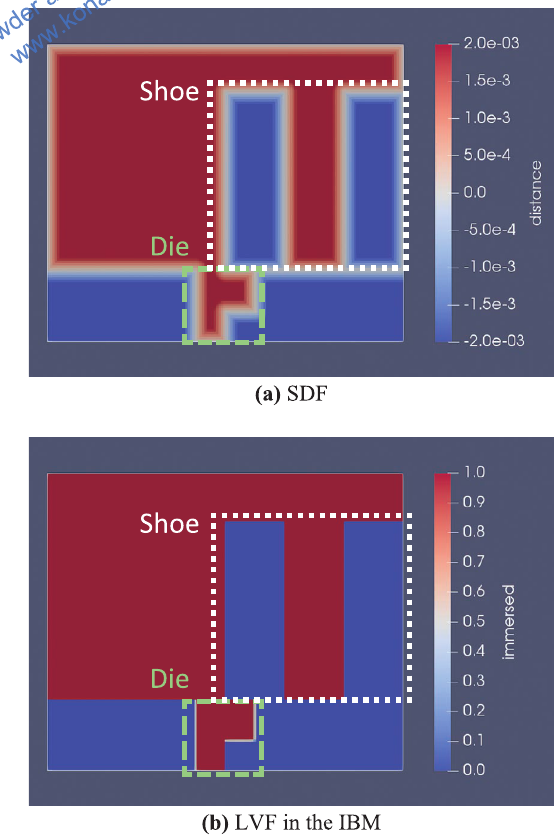
Fig. 3 Wall boundary modeling by the SDF and IBM.